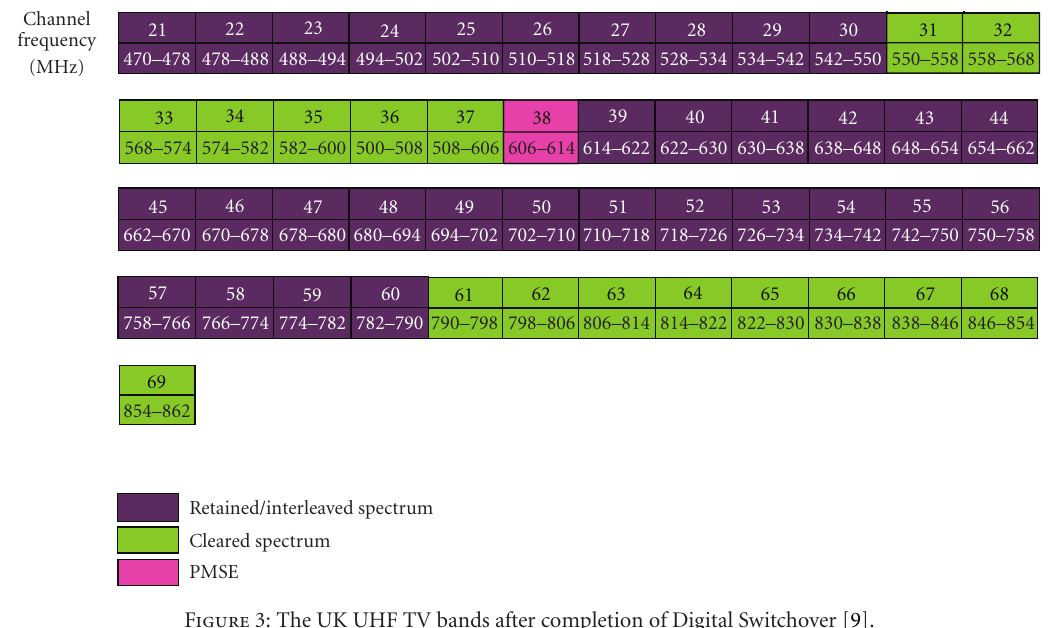
Figure 3: The UK UHF TV bands after completion of Digital Switchover